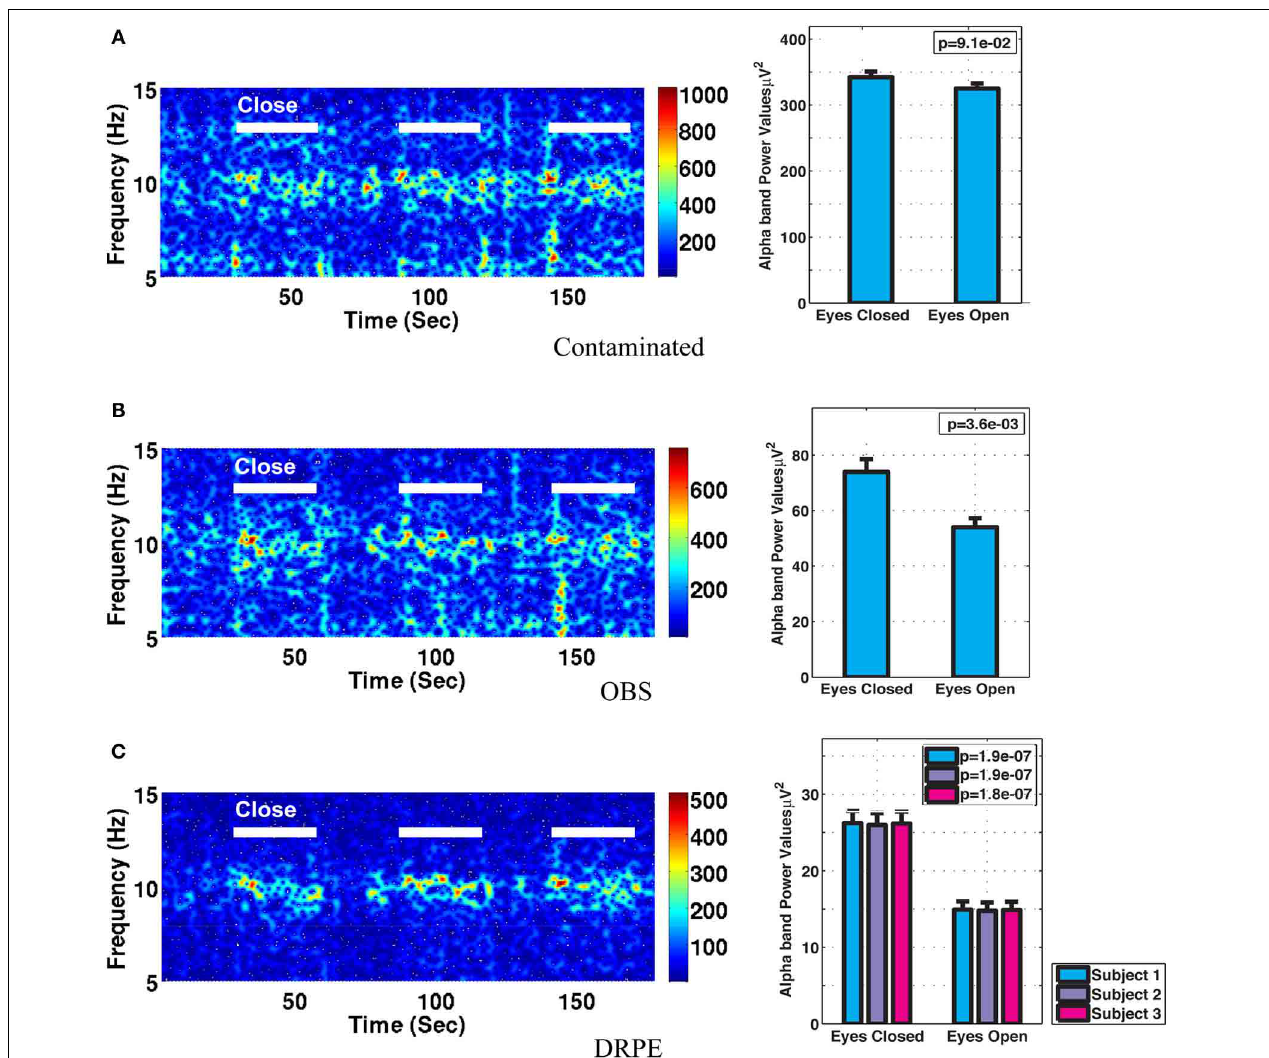
FIGURE 11 | Comparison of performance in differentiating the eyes open (EC) and eyes closed (EO) states. (A) Based directly on contaminated EEG recording, (B) recovered EEG signals with the OBS method, and (C) the proposed DRPE method. The left panel depicts the reconstructed spectrograms. The right panel displays the Wilcoxon rank test results of alpha band power comparisons between the EO and EC states; standard errors are indicated. No significant change in alpha power